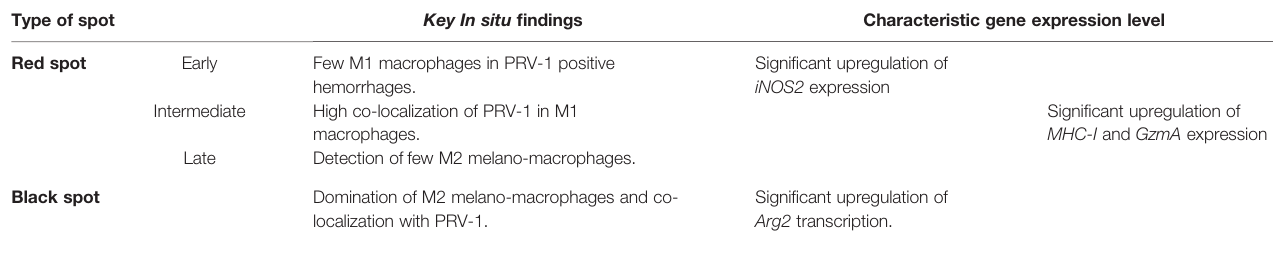
TABLE 4 | Consolidated summary of results.